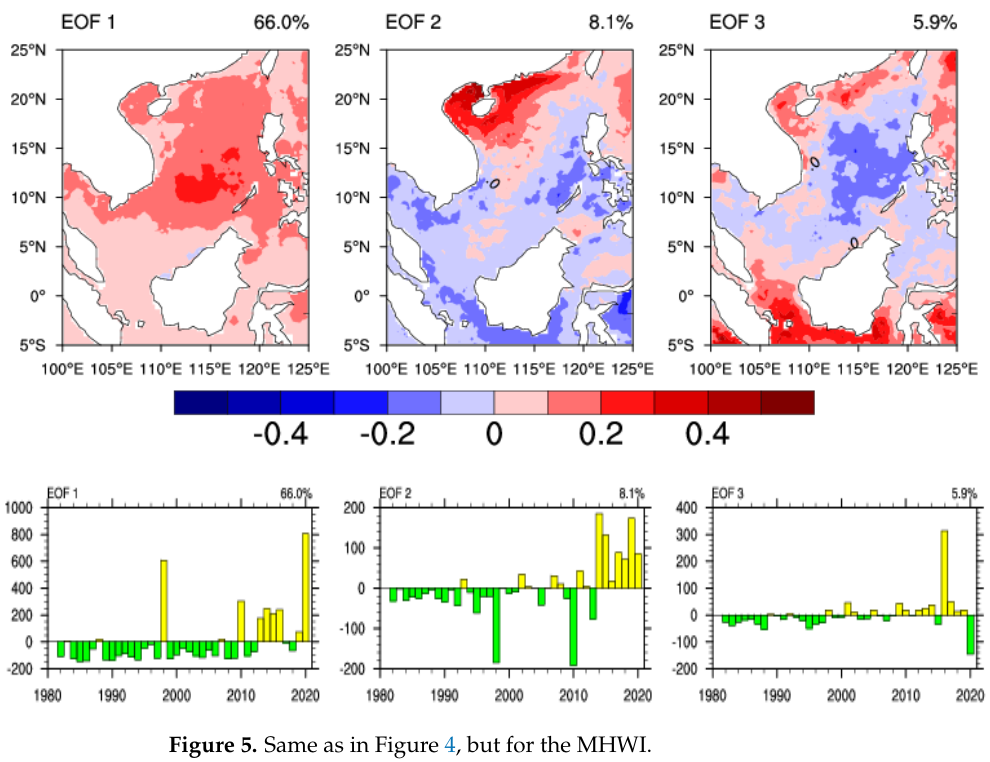
Figure 5. Same as in Figure 4, but for the MHWI.